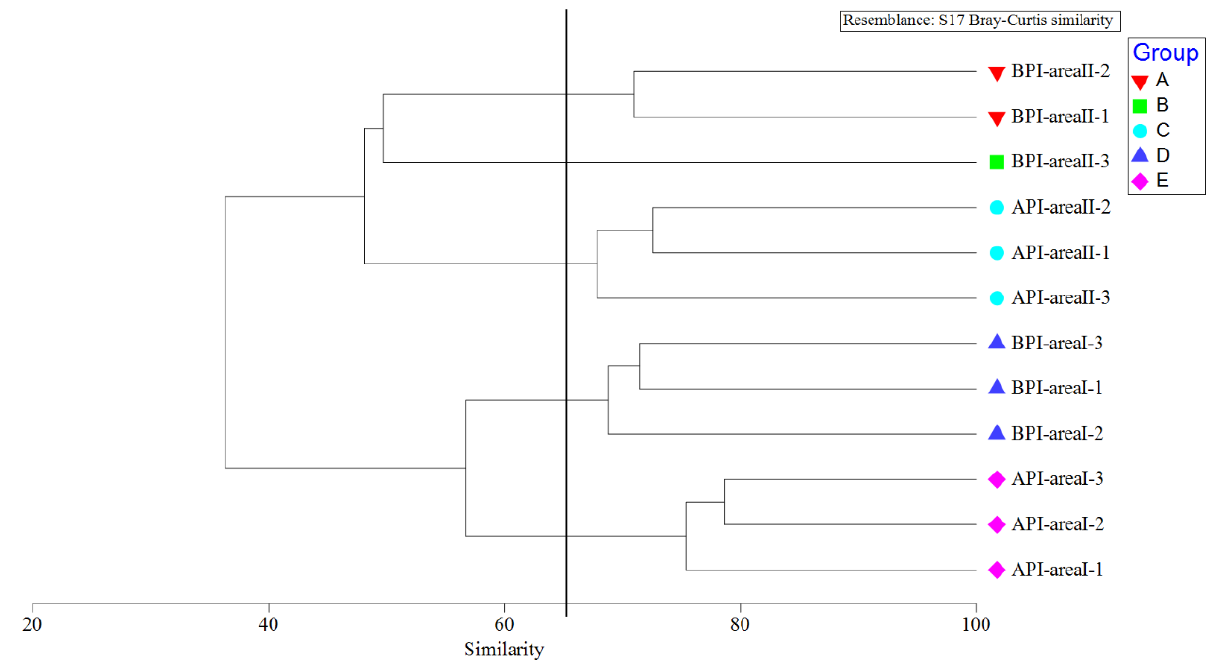
Figure 7. Cluster analysis of the fish abundance in 12 quadrats composed of 6 sampling points before and after the implementation of the project. “API-area I-1”, “API-area I-2” and “API-area I-3” represent sampling point I-1, sampling point I-2 and sampling point I-3 after the project, respectively. “BPI-area I-1”, “BPI-area I-2” and “BPI-area I-3” represent sampling point I-1, sampling point I-2 and sampling point I-3 before project, respectively. “API-area II-1”, “API-area II-2” and “API-area II-3” represent sampling point II-1, sampling point II-2 and sampling point II-3 after the project, respectively. “BPI-area II-1”, “BPI-area II-2” and “BPI-area II-3” represent sampling point II-1, sampling point II-2 and sampling point II-3 before the project, respectively.